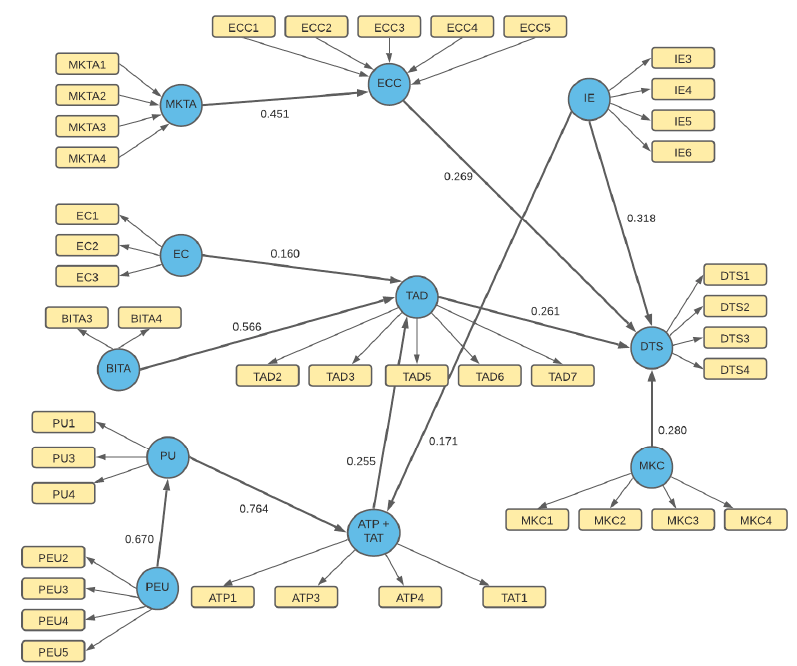
Figure 7. Debugged theoretical model.